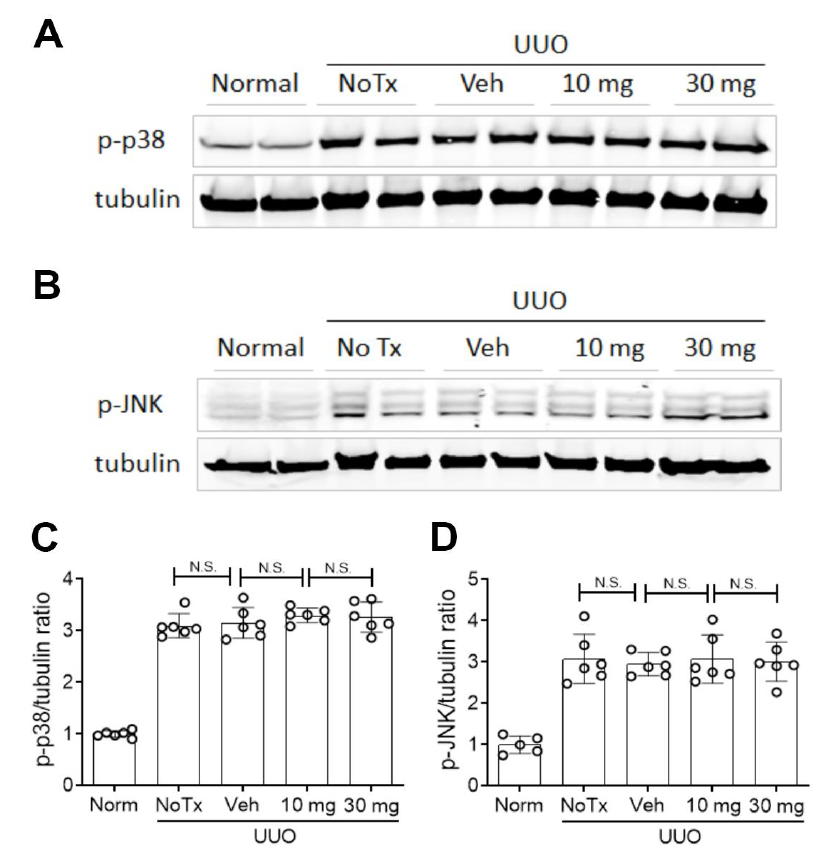
Figure 10. Stress-activated protein kinases in the day 7 unilateral ureteric obstruction (UUO) model (n = 8 to 10/group). Western blots for ( A ) phospho-p38 MAPK and ( B ) phospho-JNK, with a tubulin loading control. Graphs show quantification for ( C ) phospho-p38 MAPK and ( D ) phospho-JNK. N.S., not significant.